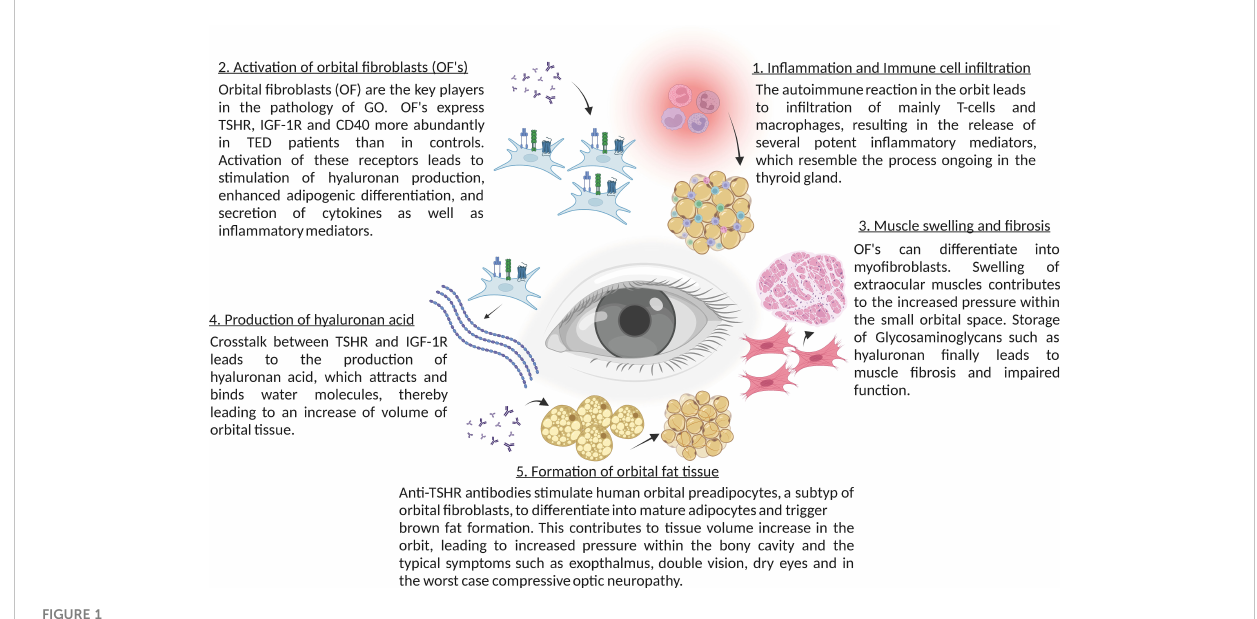
FIGURE 1 Summary of the main molecular mechanisms in thyroid eye disease